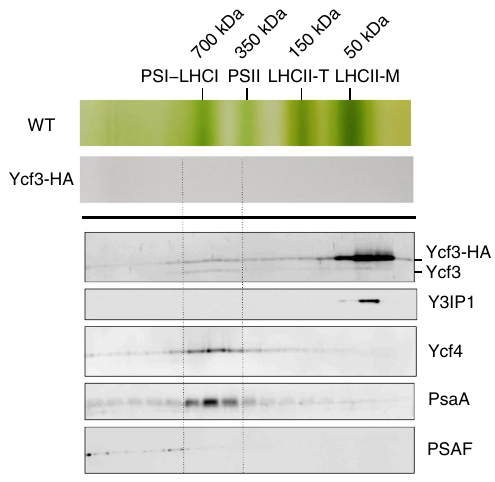
Fig. 2 Separation of Ycf3-HA preparation on SDG ultracentrifugation. The puri fi ed Ycf3-HA was concentrated and subjected to SDG ultracentrifugation, and the resulting gradient was fractionated and was analyzed by immunoblot using anti-PsaA, Y3IP1, Ycf4, Ycf3, and PSAF antibodies. Ycf3 and Y3IP1 were fractionated in the upper region of the gradient, whereas PsaA and Ycf4 were detected at positions around 700 kDa. Separation of chlorophyll – protein complexes from the WT thylakoid extracts was shown on the top as a reference to show apparent molecular sizes on the gradient. LHCII-T: trimeric LHCII, LHCI-M: monomeric LHCII